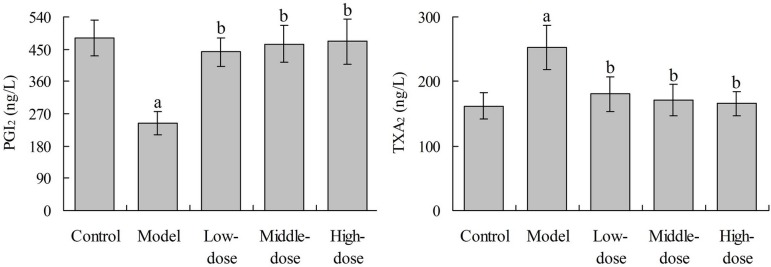
Effects of baicalin on serum PGI2 and TXA2
level in rats.aP<0.05 compared with the control group;
bP<0.05 compared with the model group.
PGI2=prostacyclin; TXA2=thromboxane
A2